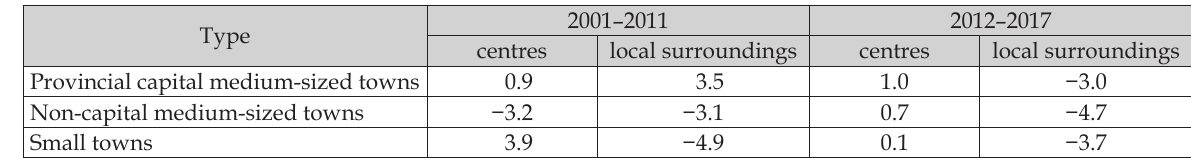
Table 3. Percentage change in the number of employees at local units: centres and local surroundings